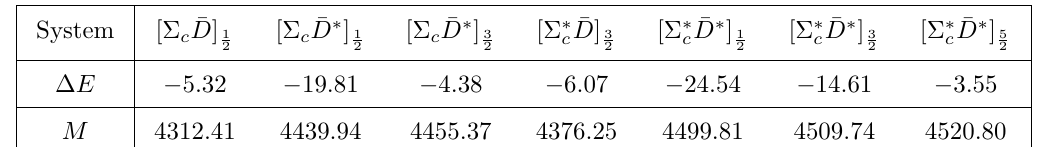
Table 5 . The binding energies and masses of the I = 1 quark model (in units of